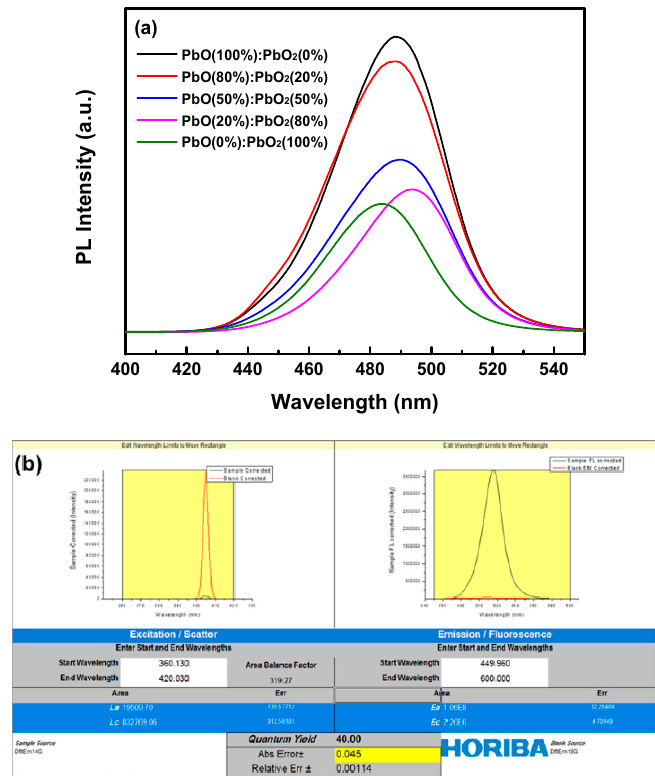
Figure 5. ( a ) Photoluminescence (PL) spectra of CsPbBr 3 -QD solutions with different PbO/recycled PbO 2 ratios; ( b ) photoluminescence quantum yield (PLQY) of CsPbBr 3